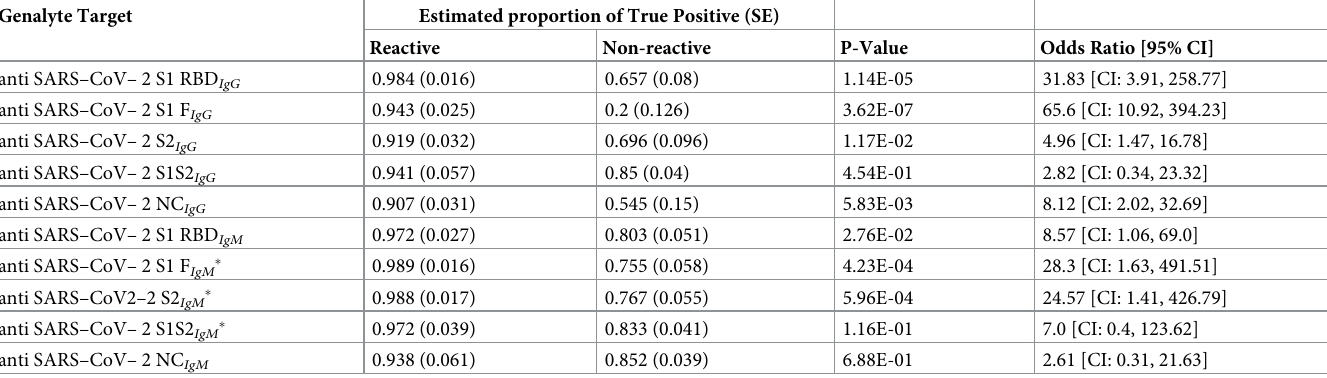
Table 4. Odds ratio of Genalyte target reactivity for true positive versus false negative samples by Beckman’s assay. Genalyte Target Estimated proportion of True Positive